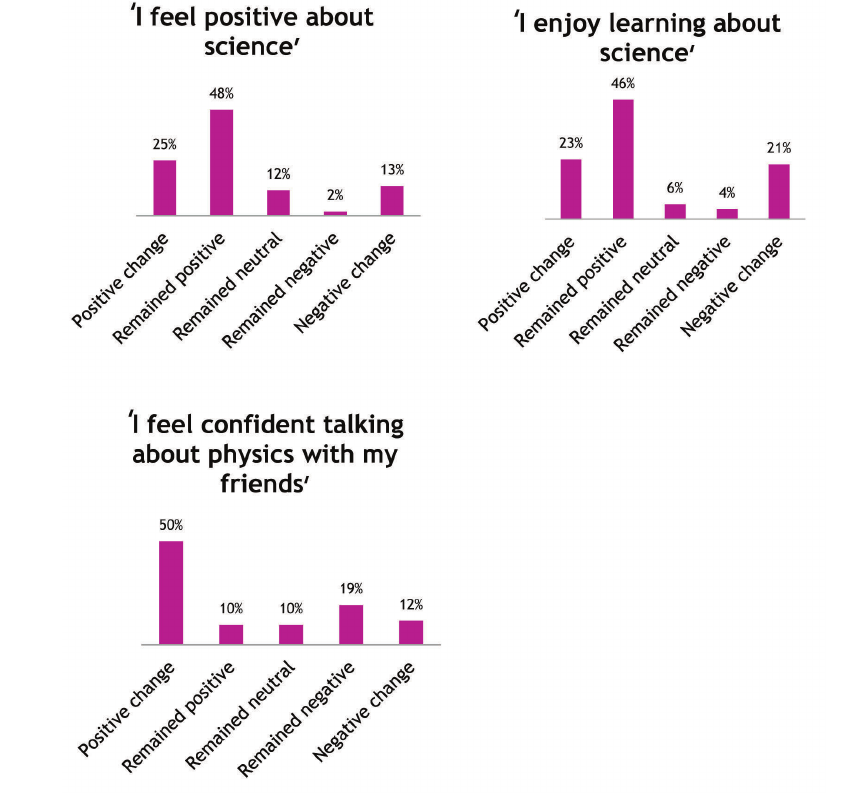
Figure 1: Charts demonstrating young people’s changes in attitude towards science over a Tactile Collider session: respondents were asked before and after the session to what extent they agreed with three statements